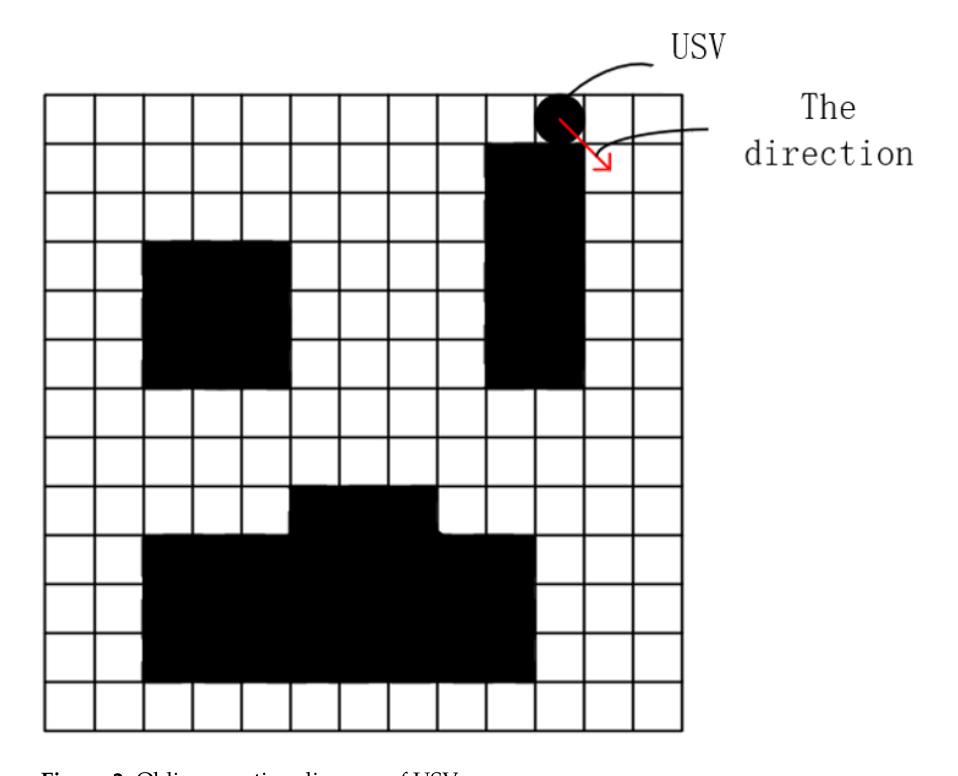
Figure 2. Oblique motion diagram of